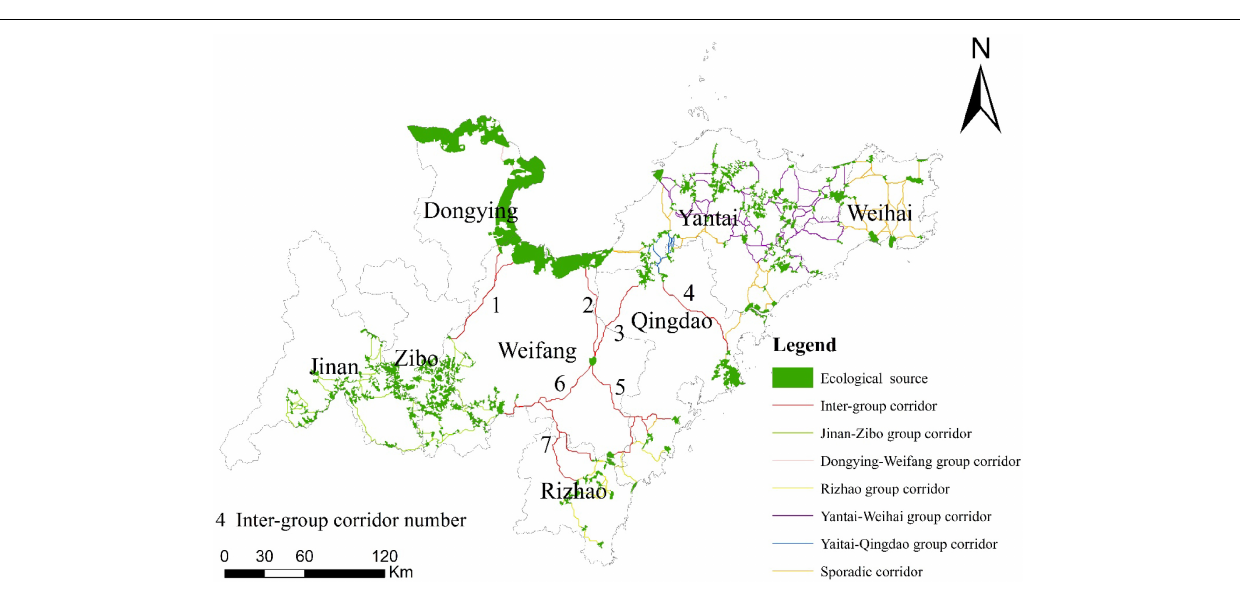
FIGURE 7 | Spatial orientation of ecological corridors in Shandong Peninsula urban